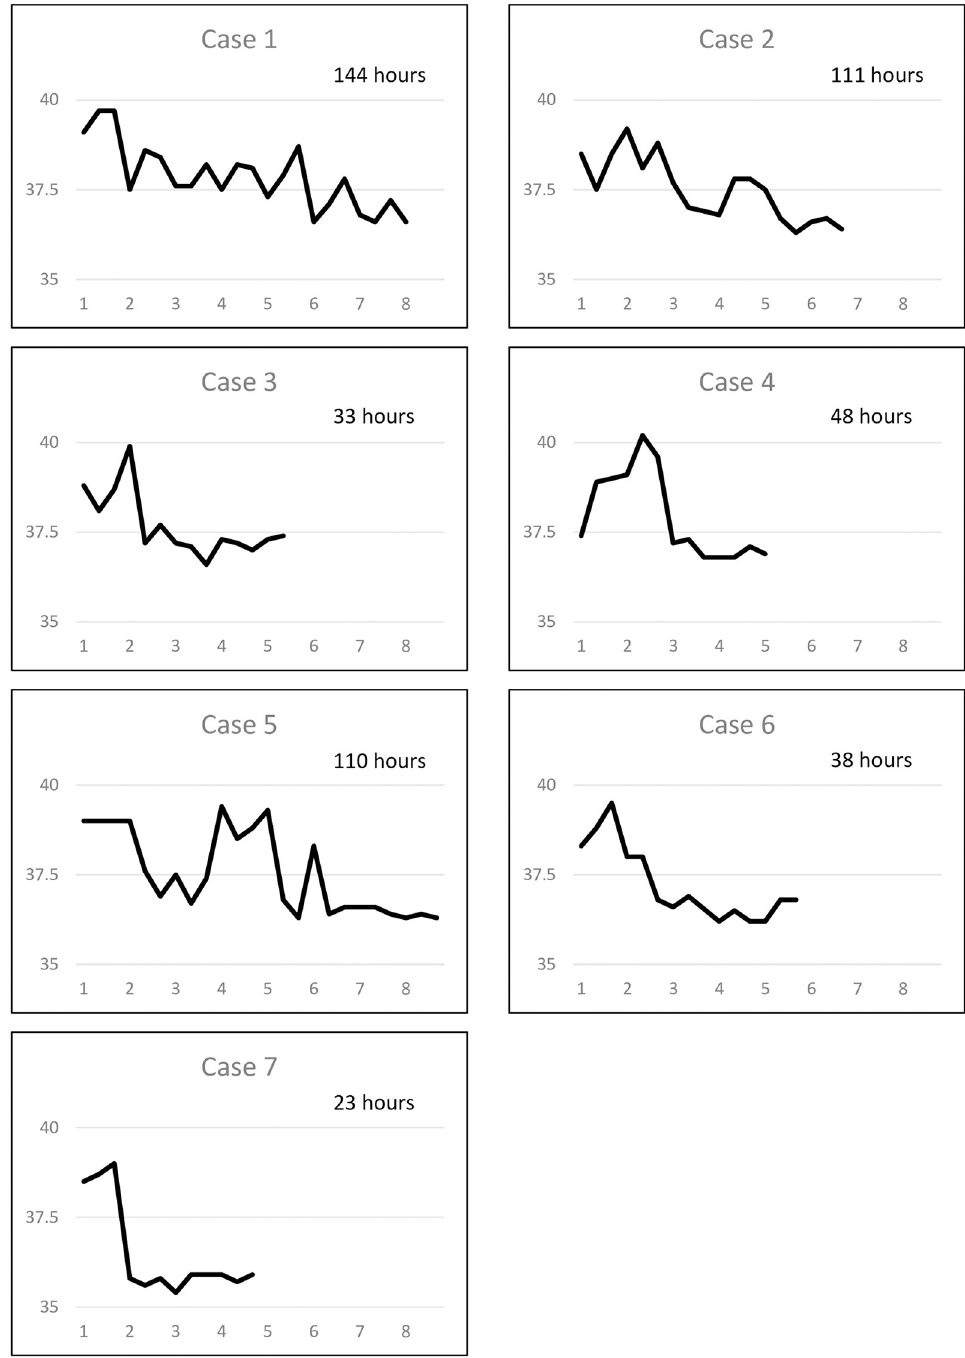
Fig 4. Temperature curve of the patients infected with influenza A/H1N1pdm09 with the H275Y mutation. Patients in cases 1–5 received oseltamivir. The patient in case 6 received laninamivir and that in case 7 received zanamivir. Fever duration is shown in the right upper field in each